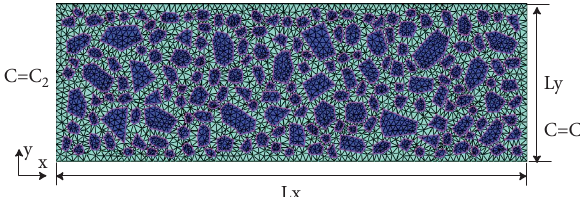
Figure 2: Schematic diagram of the model for solving the chloride difusion coefcient.